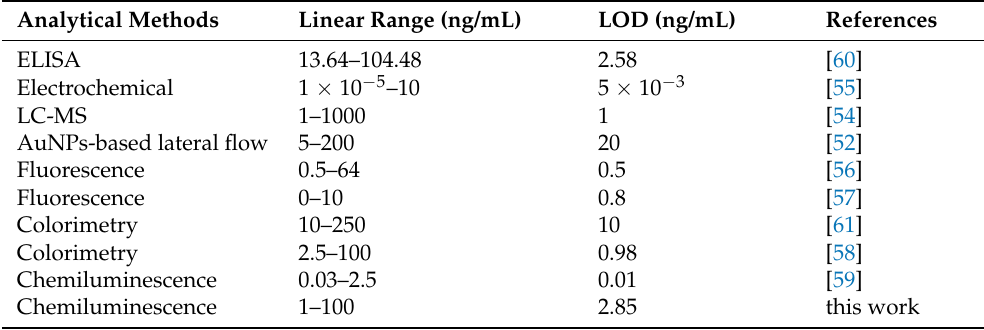
Table 1. Comparison of our chemiluminescence aptasensor with other reported analytical methods.